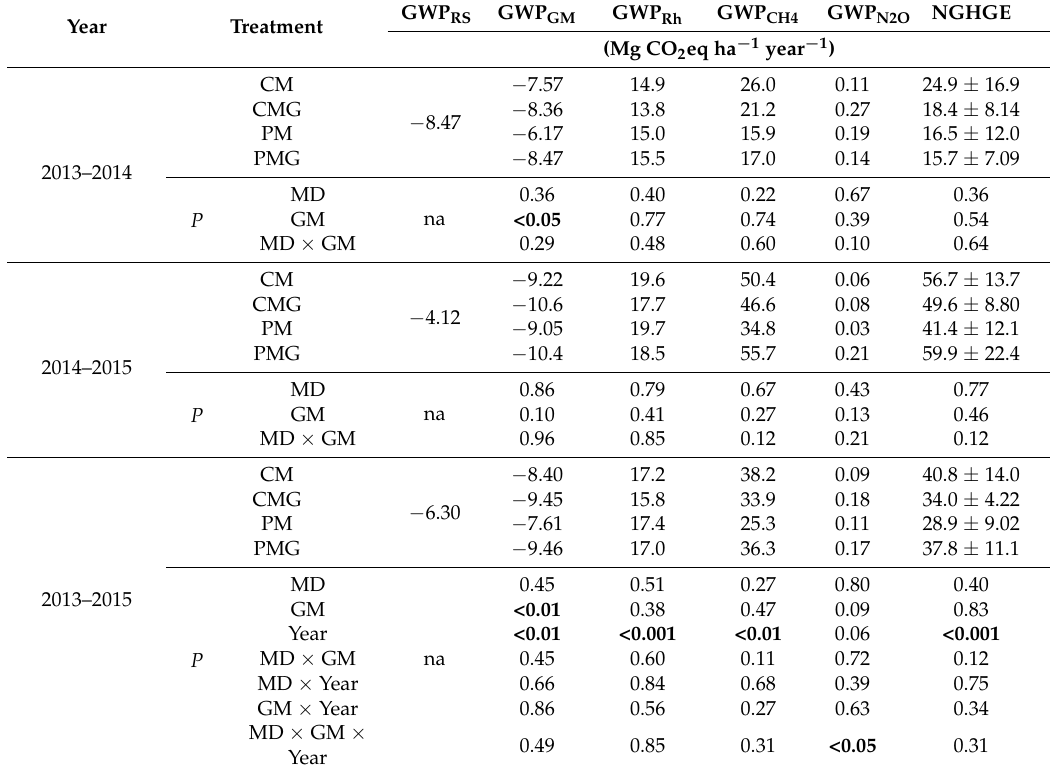
Table 3. Net greenhouse gas emission (NGHGE) (Mean ±